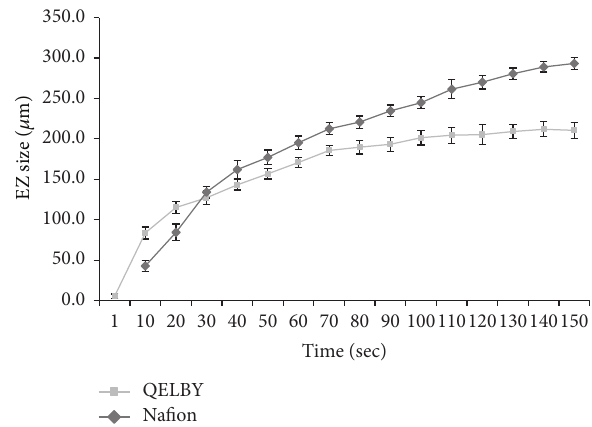
Figure 8: Rate of exclusion zone formation around QELBY particles versus next to Nafion. QELBY particles in polycarboxylate-coated 2- 𝜇 m aqueous suspension, and Nafion TT110 in polycarboxylate- coated 2- 𝜇 m microsphere suspension were placed separately in an 8-well chambered Permanox slide. The curves represent the means of three measurements.